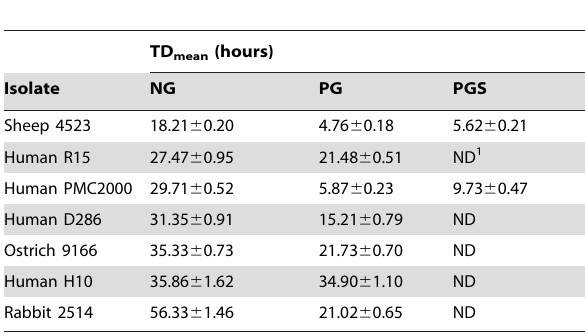
Table 3. Calculated TD mean for B. pseudomallei -infected C. elegans on NG, PG and PGS medium.